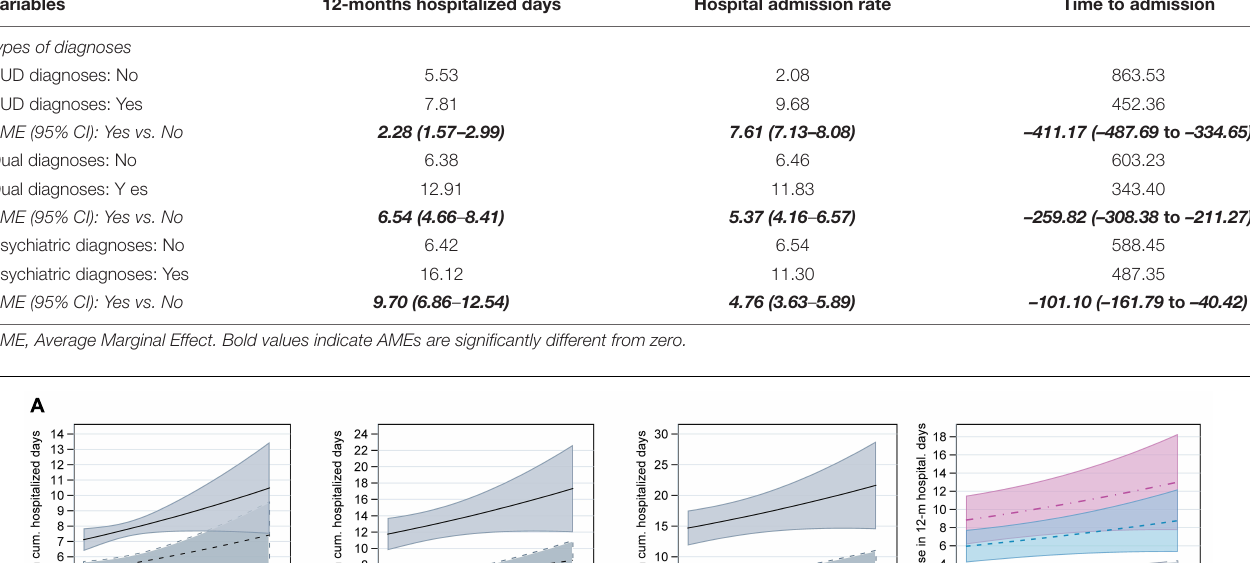
TABLE 3 | Average adjusted predictions and average marginal effects for substance use disorders (SUD), dual and psychiatric diagnoses. Variables